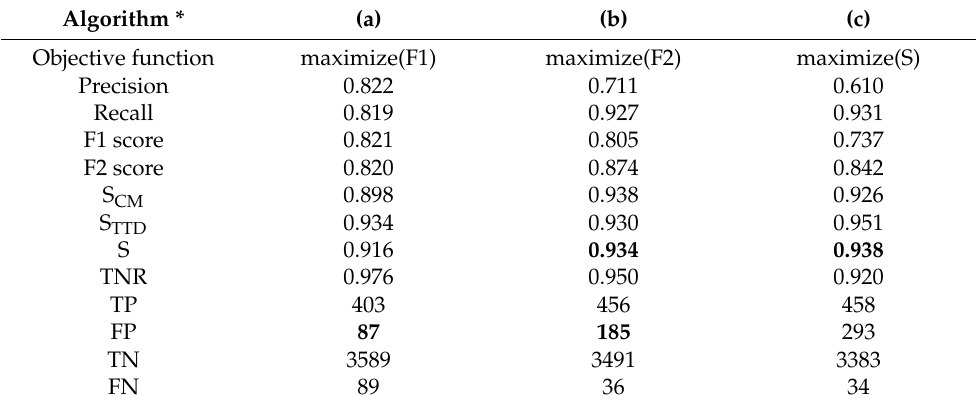
Table 2. Algorithm performance on the holdout set ( Dataset 2) using the same trained TGCN model, but different objective functions to fine-tune the attack detection threshold “ TH ” and rolling mean window length “ l